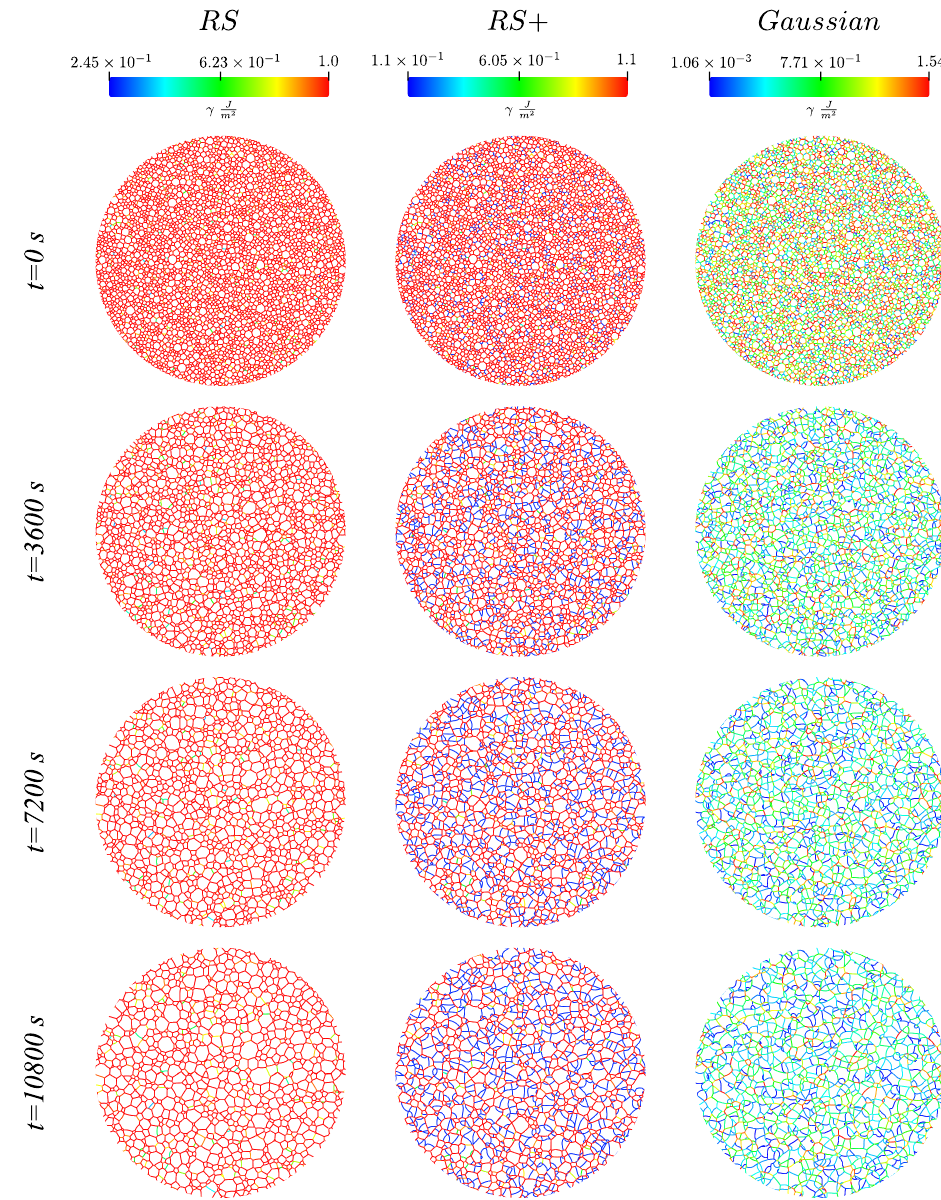
Figure 9. Examples of the evolution of the microstructure, from top to bottom as a function of time, and using the functions from right to left: RS, RS+, and Gaussian. A much higher heterogeneity is found in the cases using the Gaussian and RS+ functions. These figures illustrate the presence of stable high-order multiple